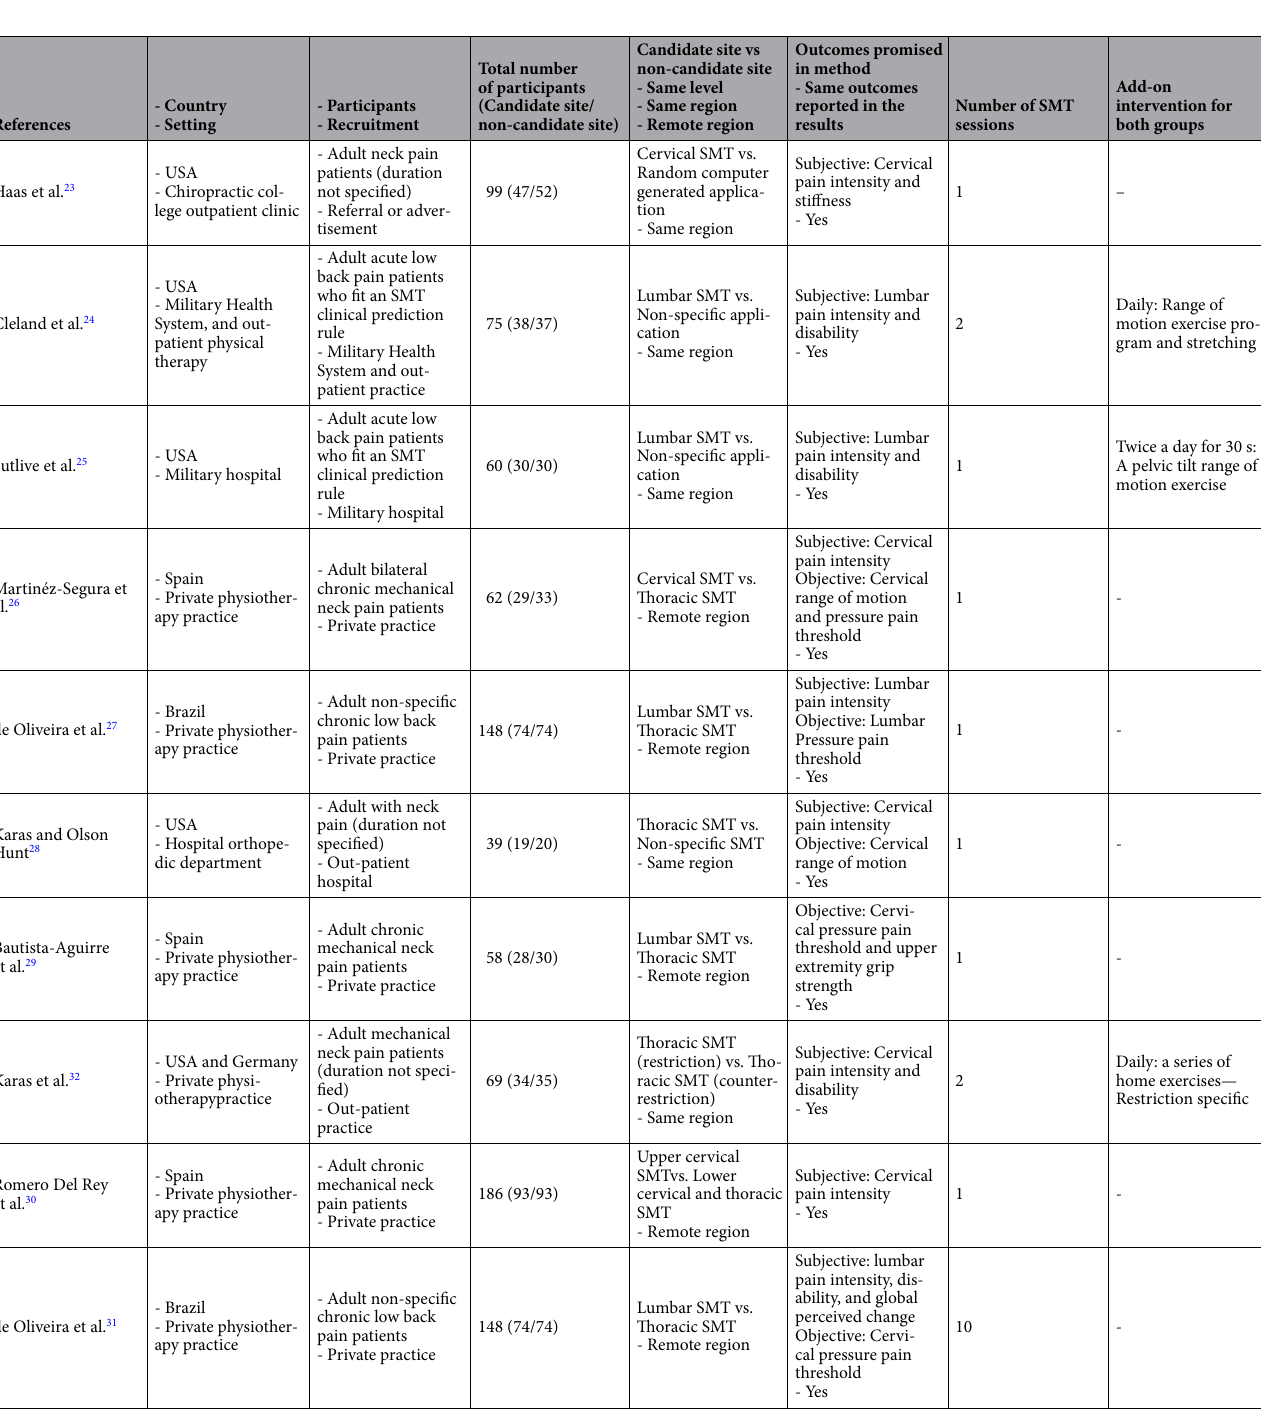
Table 1. Description of 10 studies included in a systematic review comparing the outcome of applying spinal manipulative therapy at a candidate site versus a non-candidate